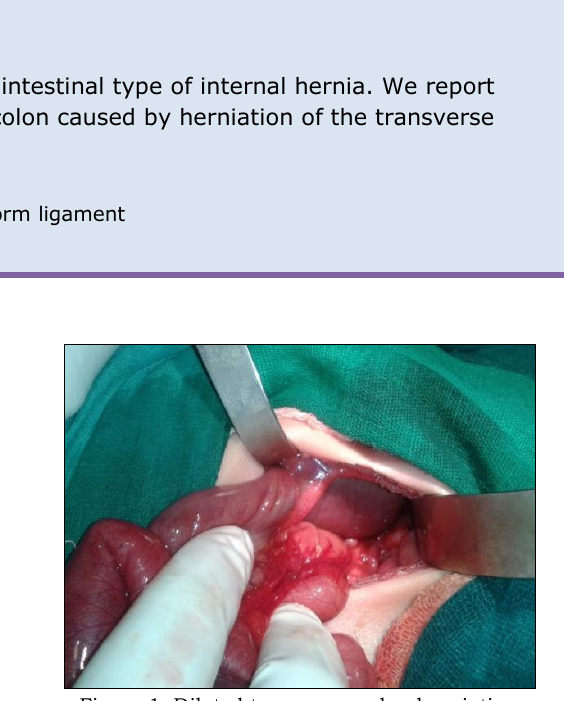
Figure 1: Dilated transverse colon herniating through falciform ligament.